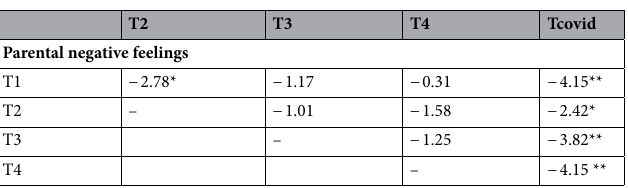
Table 1. Z-values for post-hoc pairwise comparisons on longitudinal changes in parental negative feelings (measured with brief symptom inventory subscales anxiety, depression, hostility and interpersonal sensitivity). * p < .05; ** p < .005 (Bonferroni